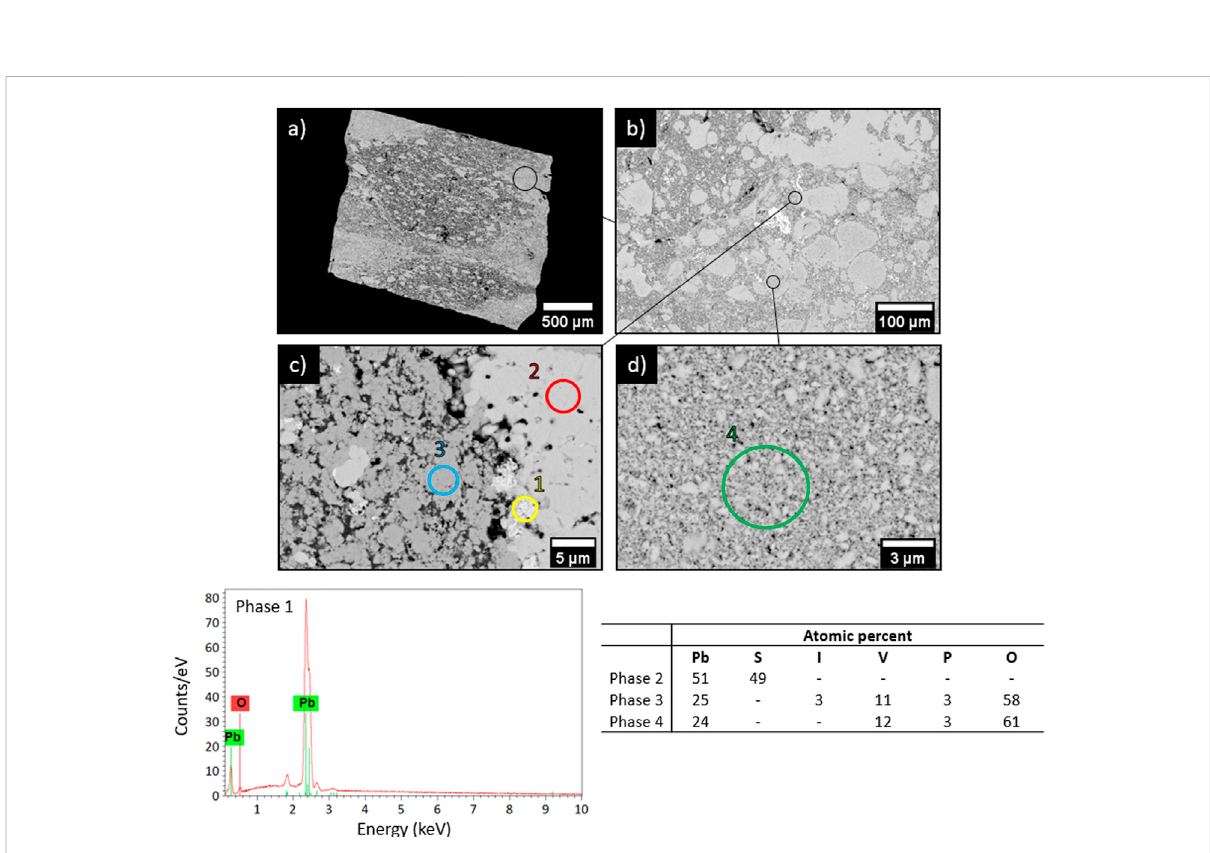
FIGURE 7 SEM pictures (BSE) (A) x34, (B) x200, (C) x3000 and (D) x6000 as well as EDS and elemental quanti fi cation of the